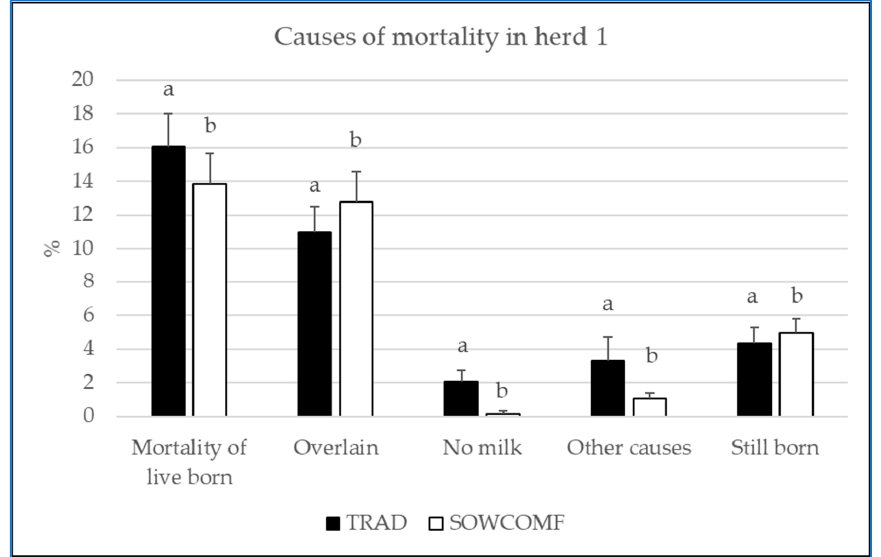
Figure 5. Causes of preweaning mortality (means + SE) in TRAD (Traditional: n = 61 litters) vs. SOWCOMF (SowComfort farrowing pen: n = 57 litters) in the first herd. Except for stillborn which was calculated as % of total born, the other variables were given as % of live born. For each variable, significant differences between the two types of pens (white and black bars) are denoted by different superscripts a and b. Table 2. Production results (means ± SE) from the first farm during the three first batches of TRAD (Traditional: n = 61 litters) followed by two consecutive batches in SOWCOMF (SowComfort far- rowing pen: n = 57 litters). Significant differences between each batch within pen type for all varia- bles are denoted by different superscripts a, b, and c. TRAD SOWCOMF